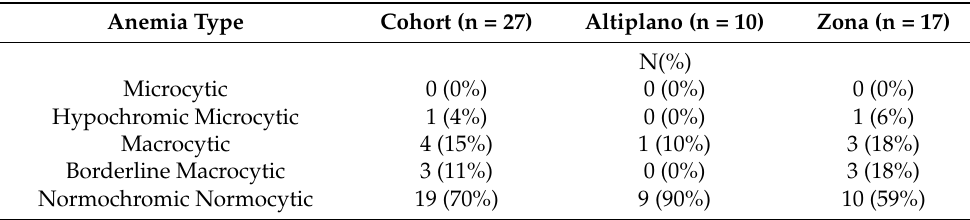
Table 7. Anemia type among 27 sugarcane workers with low hemoglobin.